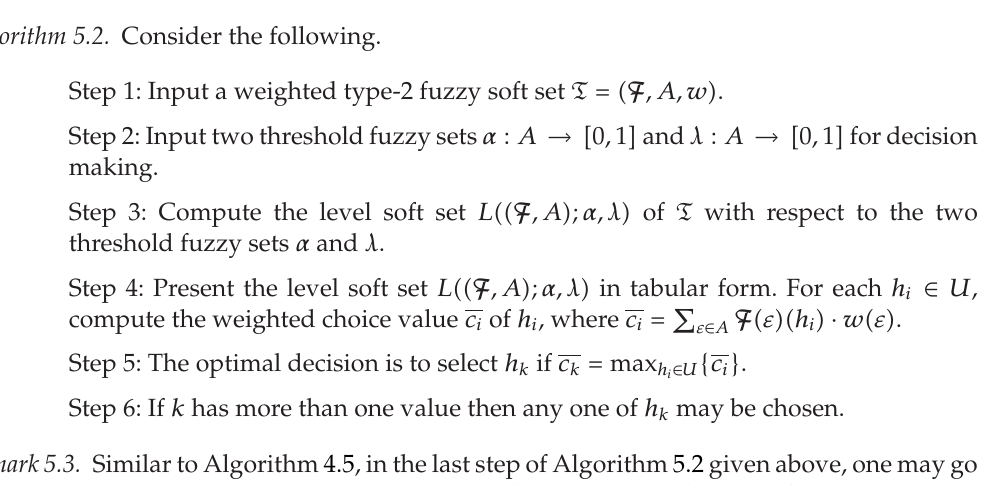
Algorithm 5.2. Consider the